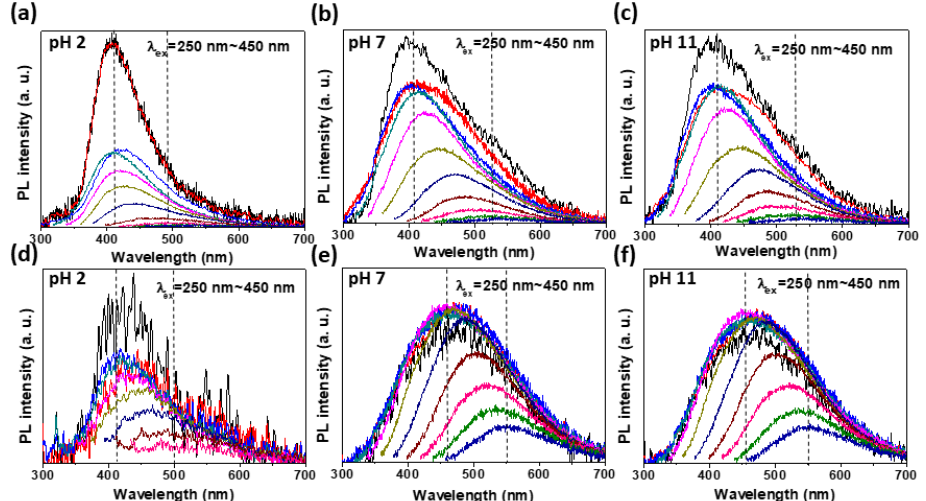
Figure 3. Excitation wavelength-dependent Photoluminescence (PLE) spectra. ( a – c ). PLE spectra of MoSe 2 - m QD- S excited by λ Ex ~250 (black), 270 (red), 290 (blue), 310 (dark cyan), 330 (Magenta), 350 (dark yellow), 370 (navy), 390 (wine), 410 (pink), 430 (olive), 450 (royal) nm, respectively, at pH 2 ( a ), pH 7 ( b ), and pH 11 ( c ). The gap between excitation wavelengths is 20 nm. ( d – f ). PLE spectra of MoSe 2 - m QD- L excited by λ Ex ~250 – 470 nm at pH 2 ( d ), pH 7 ( e ), and pH 11 ( f ). The gap between excitation wavelengths is 20 nm.